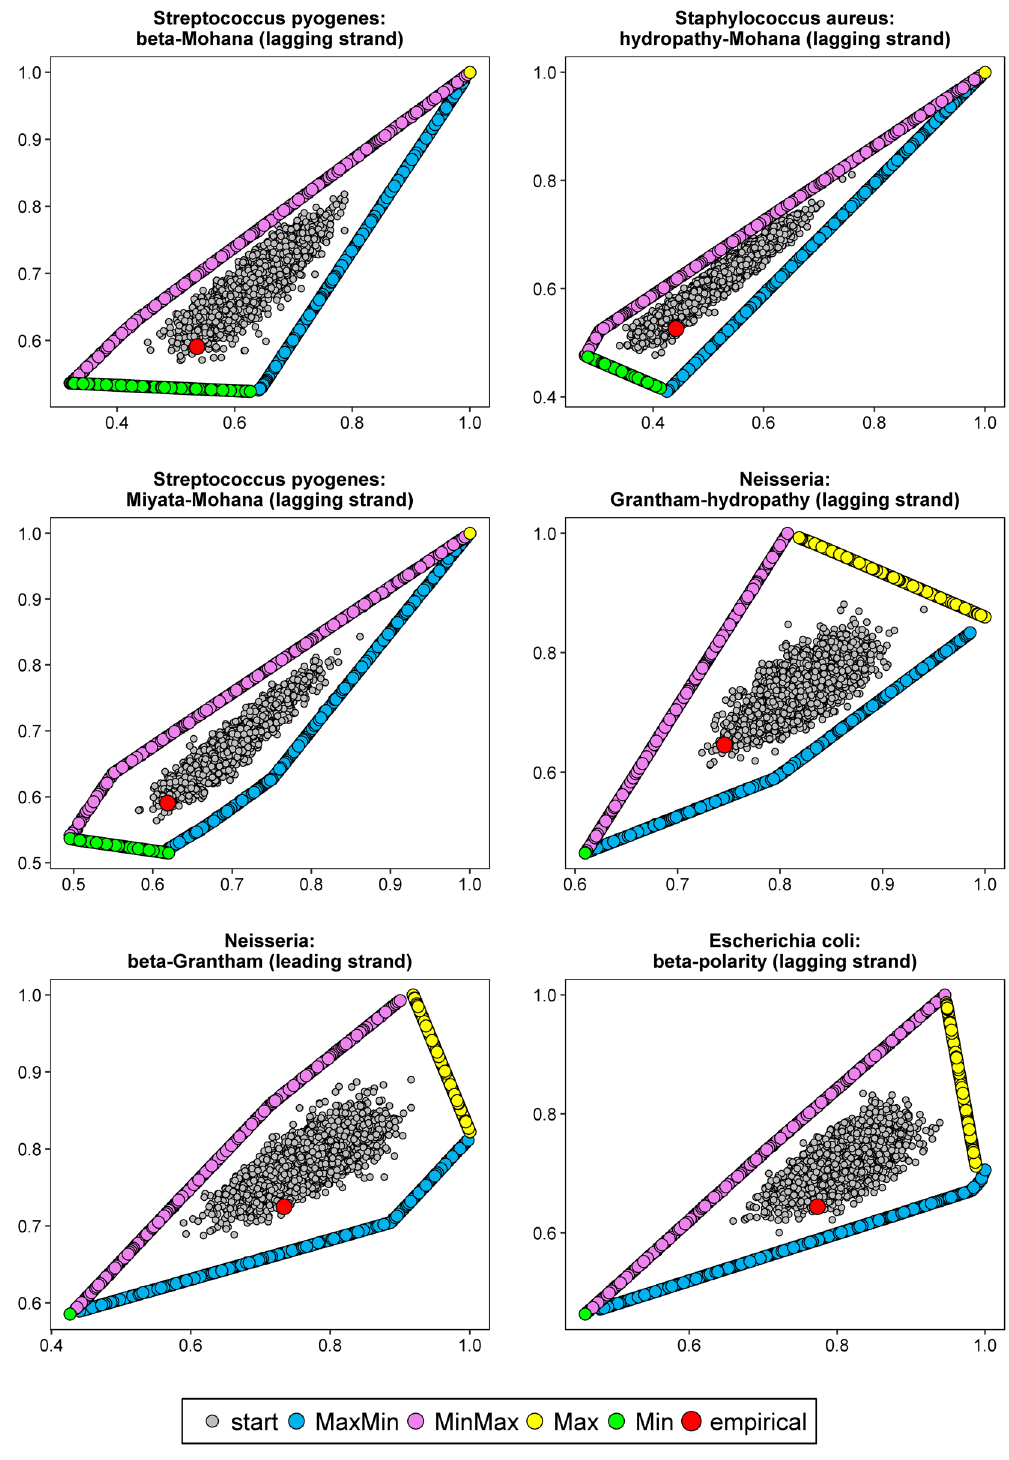
Figure 5. As in Fig.